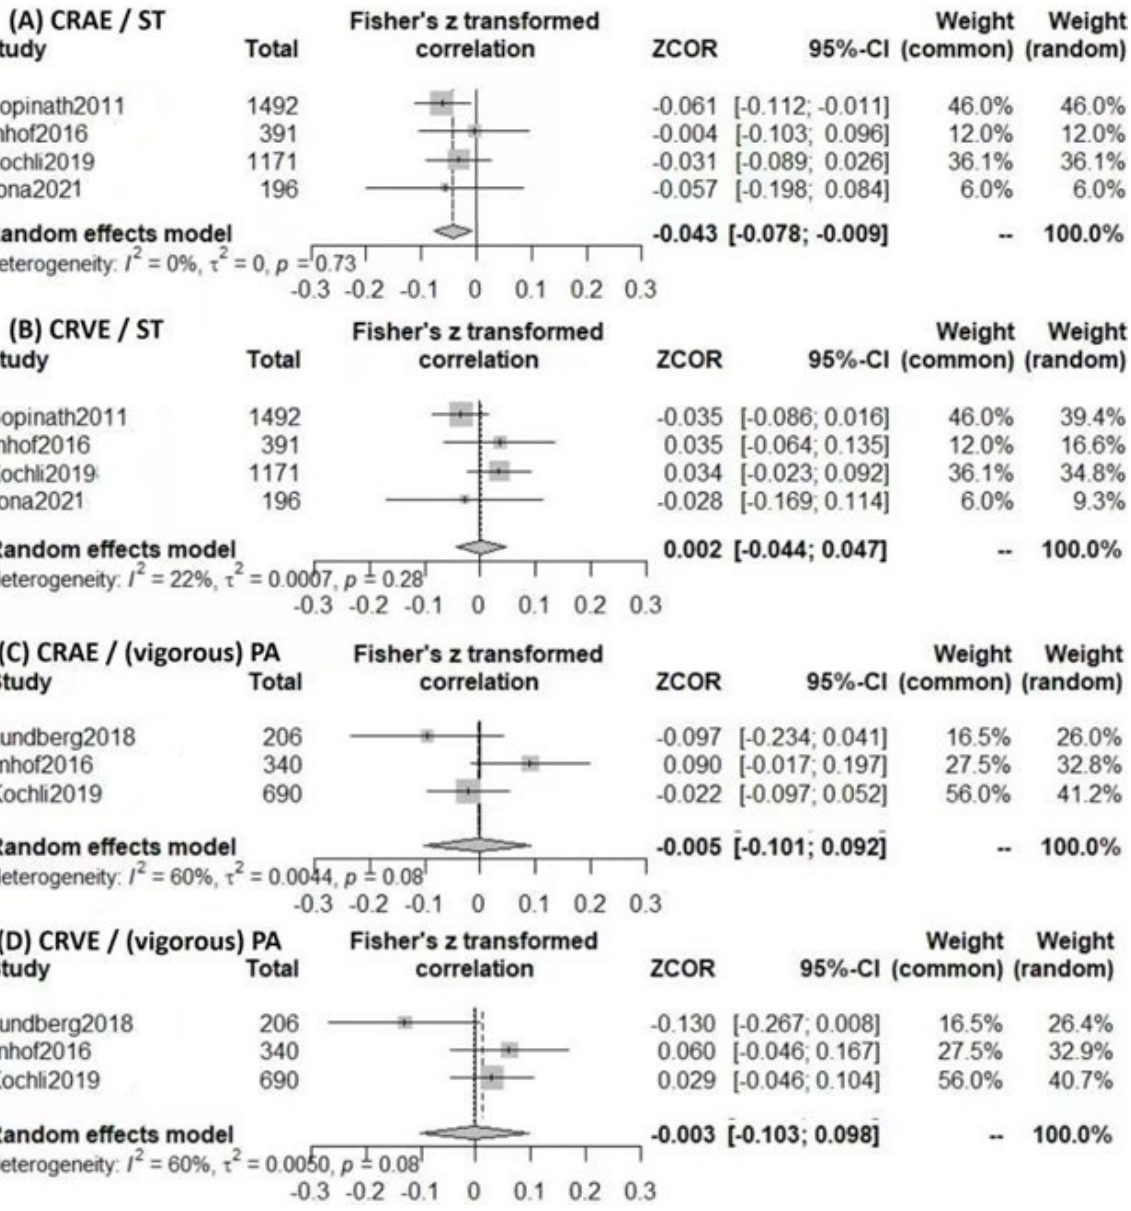
Figure 2. ( A , B ) The associations of screen time with retinal vascular calibers for children and adolescents. ( C , D ) The associations of vigorous PA with RVC for children and adolescents. CRAE: central retinal arteriolar equivalent; CRVE: central retinal venule equivalent; ST: Screen time; PA: physical activity[3,6,8,11,12] .